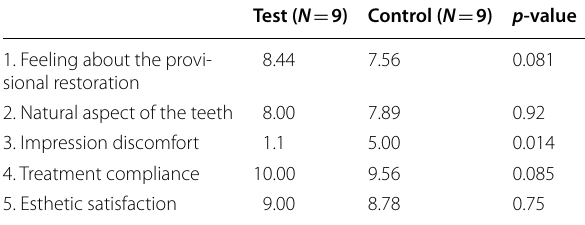
Table 4 PROMs (patient-reported outcome